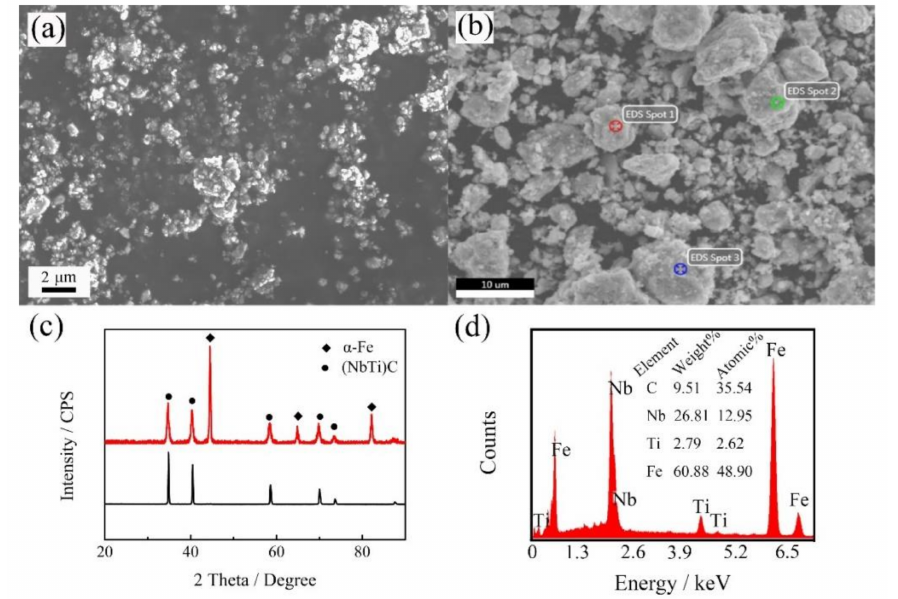
Figure 1. ( a ) SEM morphology of (NbTi)C; ( b ) SEM morphology of (NbTi)C/Fe particles; ( c ) XRD patterns of powder from Figure 1a black line and Figure 1b red line; ( d ) EDS result of spot 1 in Figure 1b.